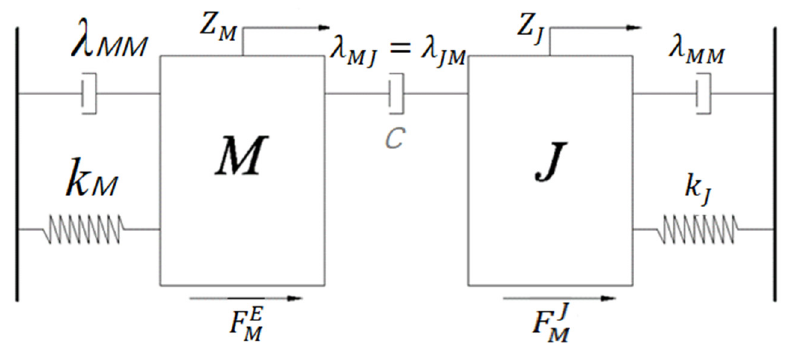
Figure 2. Double-degree-of-freedom vibration system.